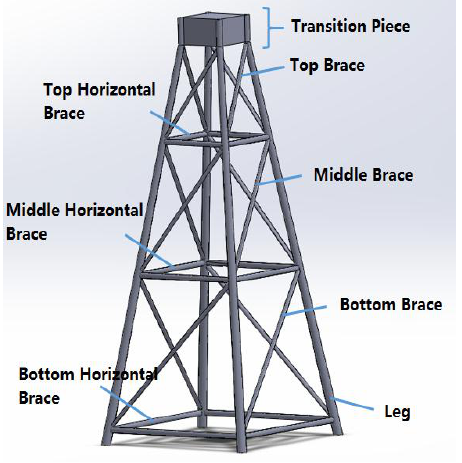
Figure A1. Terminology of the structural members of a J-structure. Table A1. Specification of three J-structures.